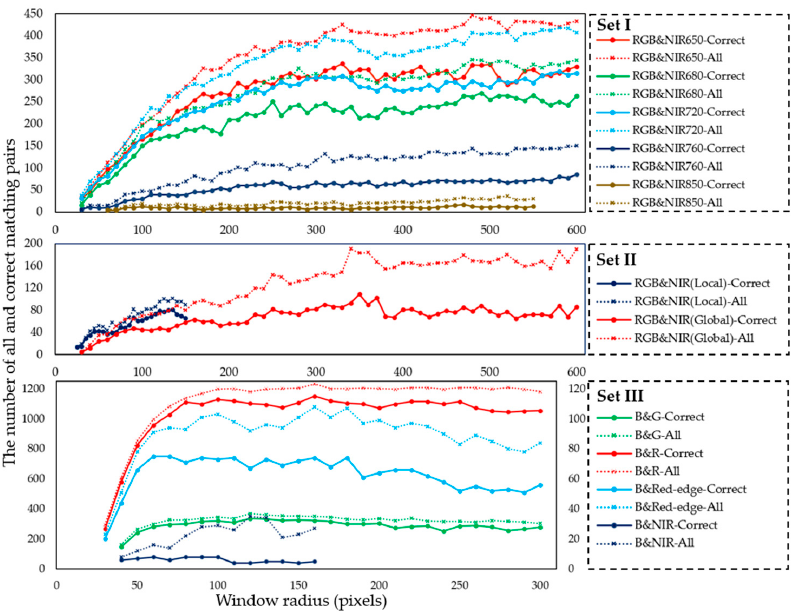
Figure 10. Trend graphs of the numbers of all of and the correct matching pairs for different window radiuses. In Set III, the right y -axis shows the scale for Blue & Red-edge and Blue & NIR.